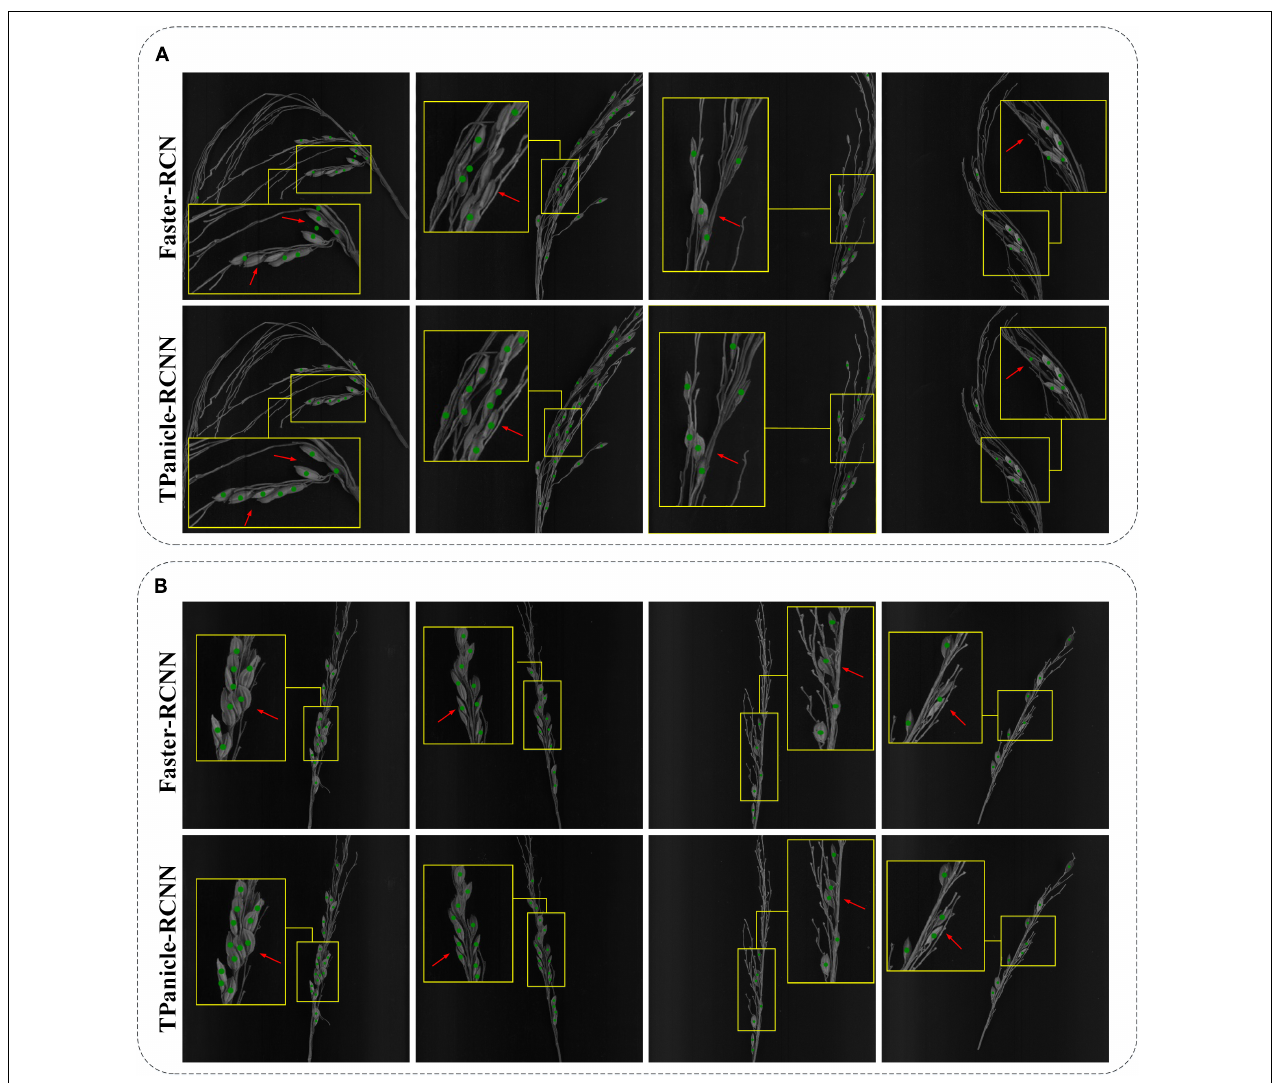
FIGURE 12 | Threshed panicle identification of the indica (A) and japonica (B) subspecies for the Faster-RCNN model and TPanicle-RCNN model. The red arrow indicates the comparison of the identification results by different